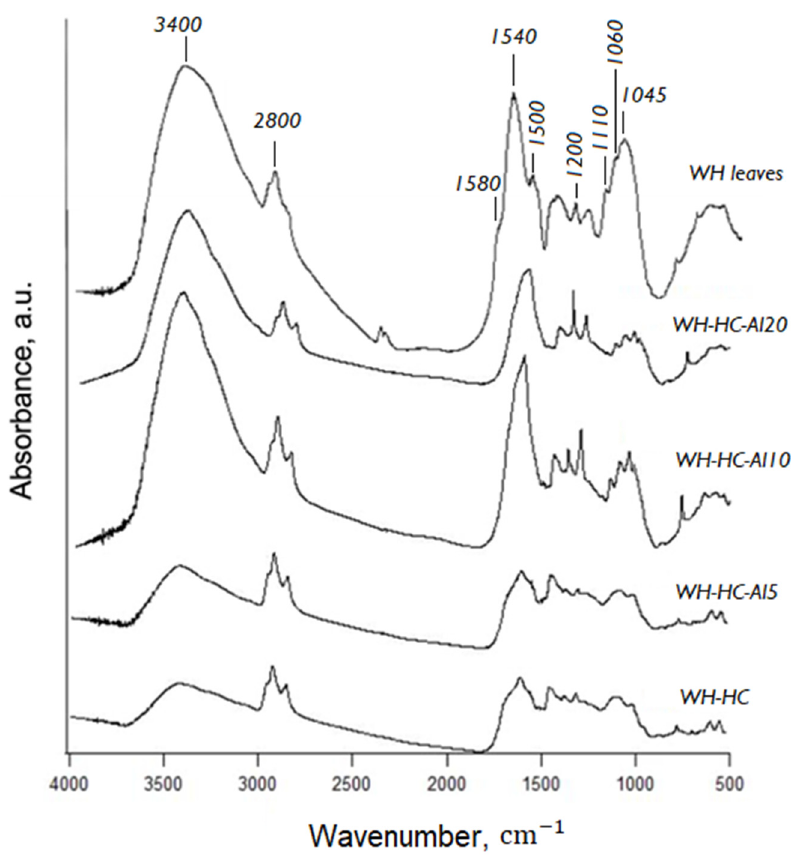
Figure 3. FT-IR spectra of WH, uncatalyzed HC and HCs prepared by Al-assisted HTC